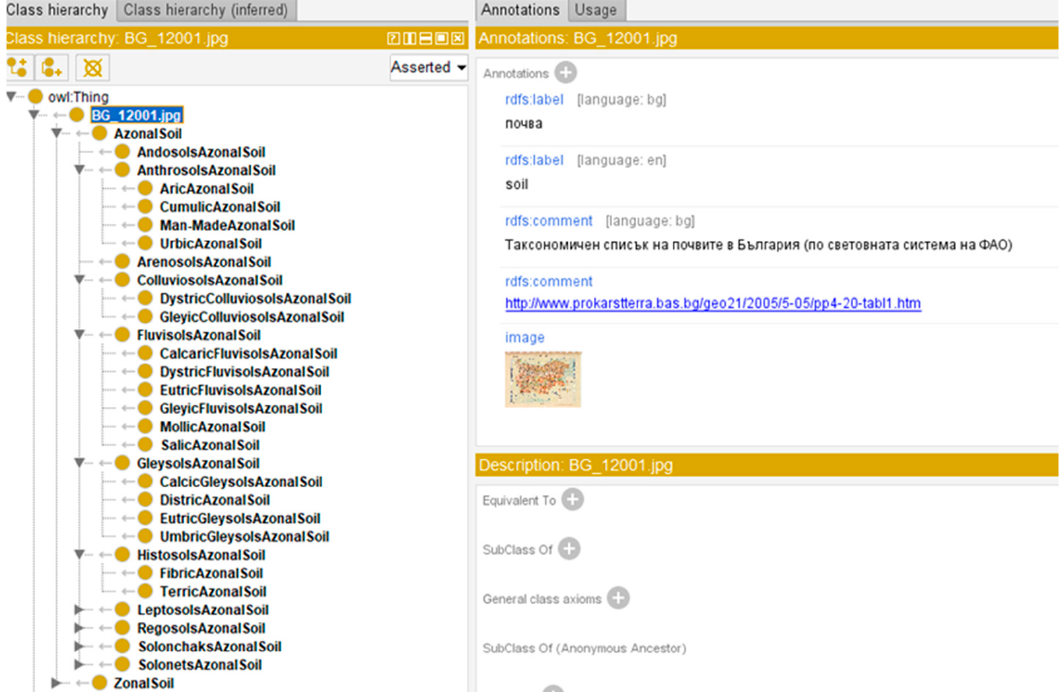
Figure 12. Bulgarian soil taxonomy in the SoilOntology.